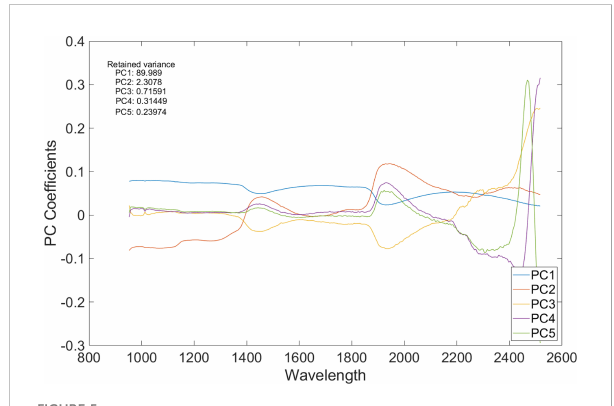
FIGURE 5 A plot of principal component analysis (PCA) coef fi cients vs. wavelength of the SWIR HS